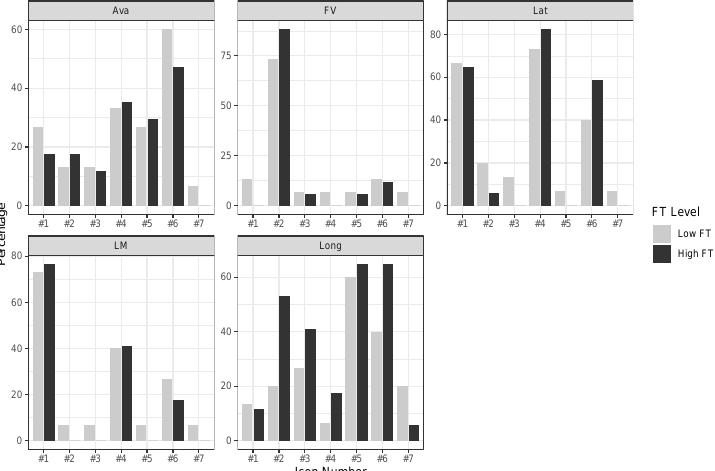
Figure 11. Percentages of VW HMI icons used to answer TRASS questions from participants with high and low